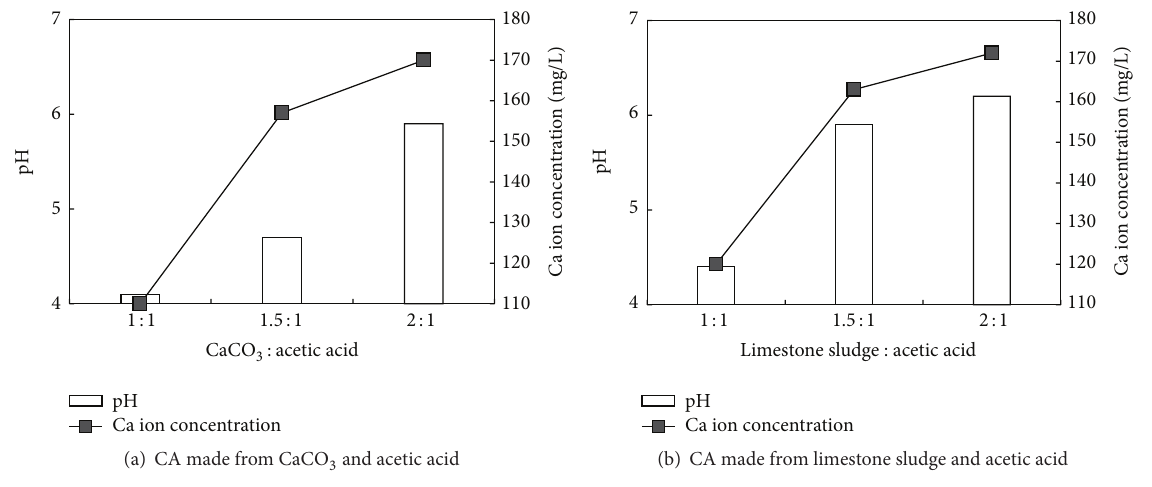
Figure 5: pH and Ca ion concentration of calcium acetate.